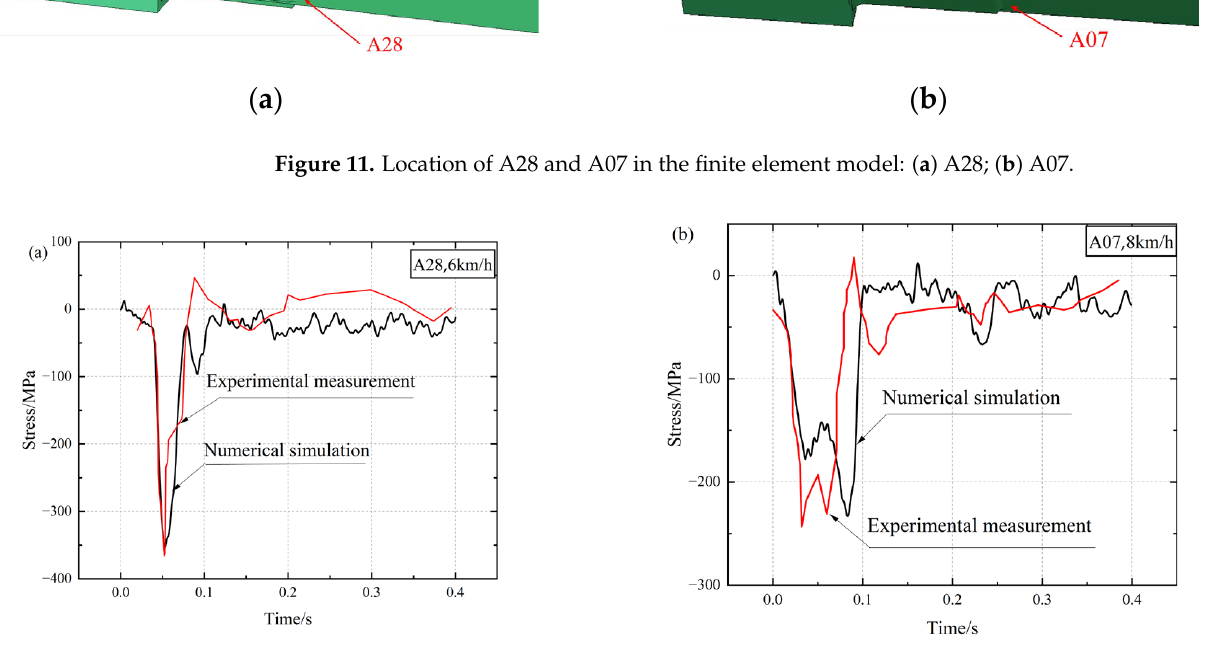
Appl. Sci. 2023 , 13 , 1351